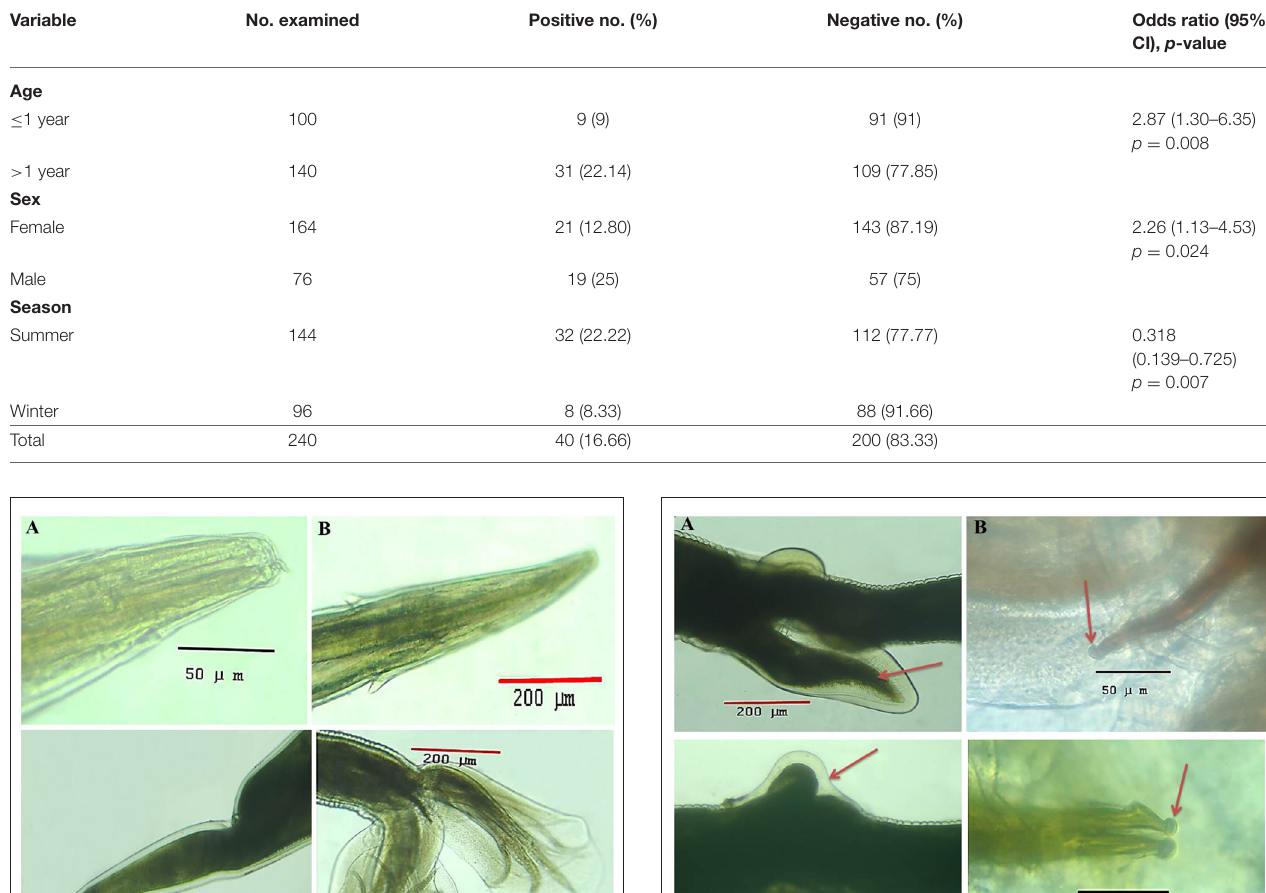
TABLE 1 | Risk factors and prevalence of hemonchosis in goats after adjusting for age, sex, and season. Variable